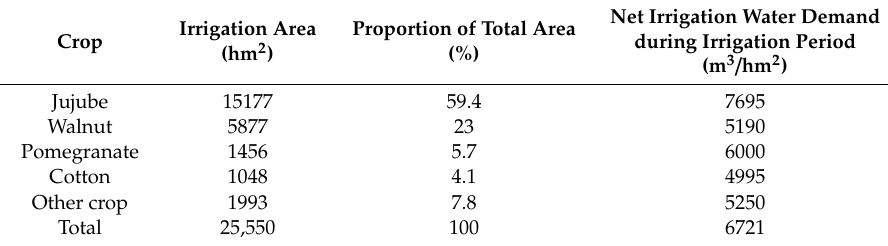
Table 1. Crop irrigation area and water demand.